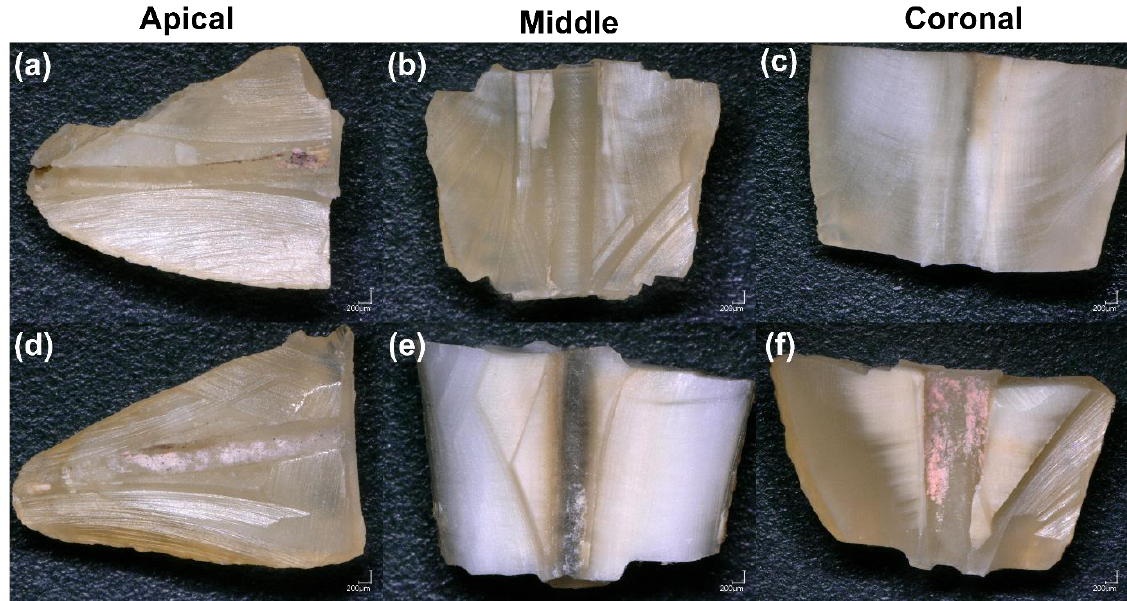
Figure 4. Digital microscope images demonstrate the effectiveness of the retreatment technique with irrigant activation ( a – c ) and without irrigant activation ( d – f ) in the apical, middle, and coronal thirds of the root